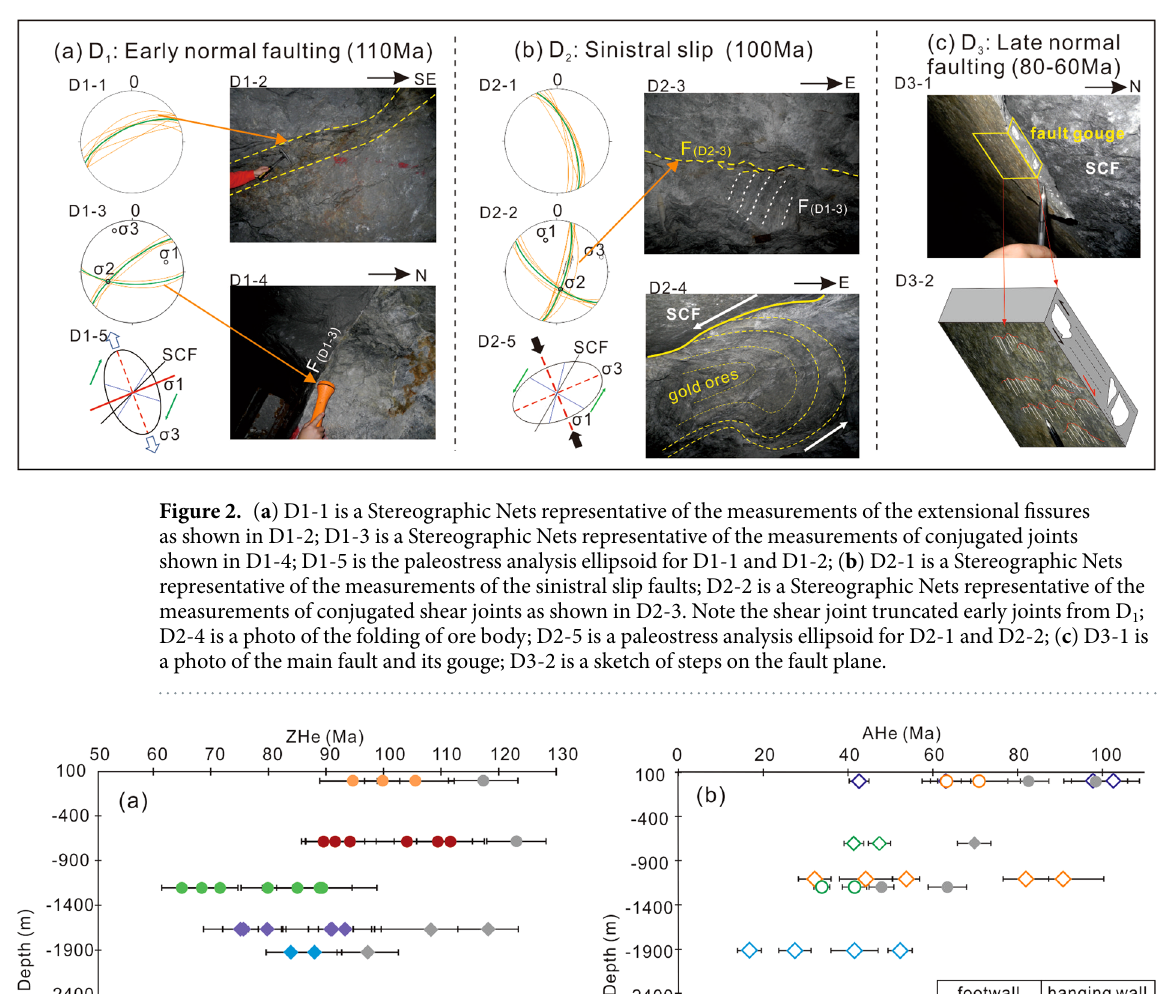
Causes of outliers and age dispersion.